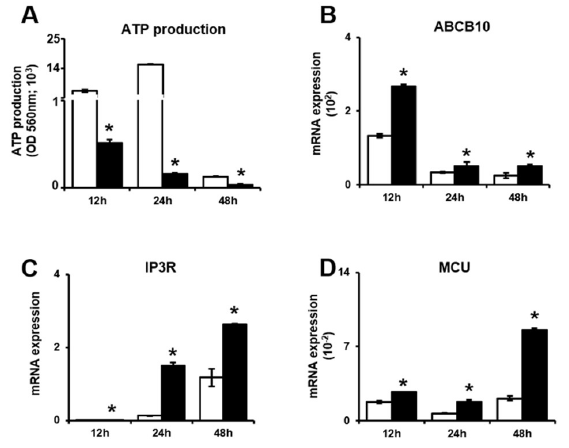
Figure 2. PD-MSCs increased ATP consumption through calcium channel activity in the mitochondria of invasive trophoblasts. ( A ) ATP production in invasive trophoblasts with and without PD-MSC cocultivation was determined by ELISA. The mRNA expression of ( B ) ABCB10, ( C ) IP3R and ( D ) MCU in invasive trophoblast cells with and without PD-MSC cocultivation over time. The data was performed in at least triplicate and expressed as the means ± S.D. Indicates * p < 0.05. White bar: control, Black bar: PD-MSC cocultivation. *: control vs. PD-MSC cocultivation at each time point. PD-MSCs: Placenta-derived mesenchymal stem cells; ATP: Adenosine triphosphate; ELISA: Enzyme-linked immunosorbent assay; ABCB10: ATP binding cassette B member 10; IP3R: Inositol trisphosphate receptor; MCU: Mitochondrial calcium